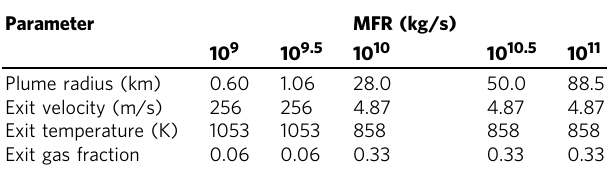
Table 3 Input parameters for BPT model inferred from three-dimensional simulations